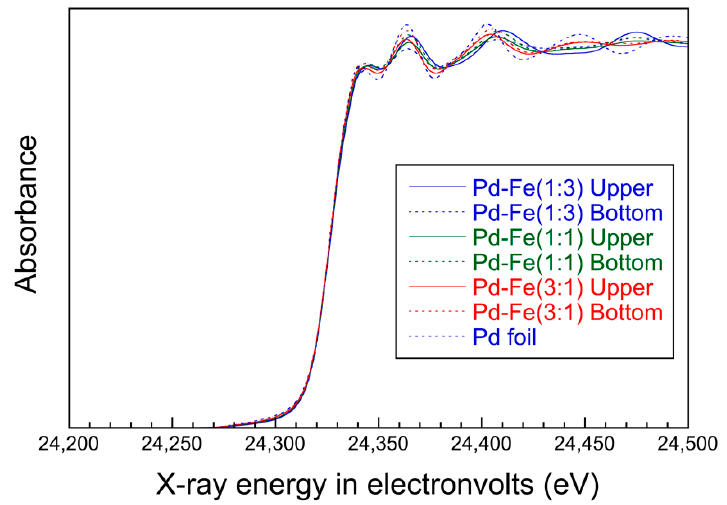
Figure 8. Normalized XANES of Pd parts of nanoparticles.